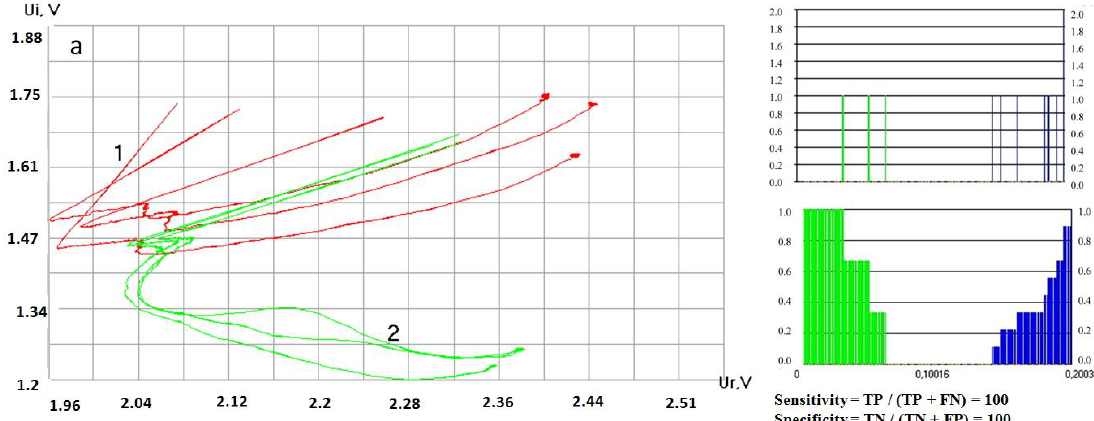
Figure 6. Software interface. ( a ) Hodographs of electrical impedance: sample 1—port wine “777” (Russia) and sample 2—vermouth “Martini Bianko” (Italy). ( b ) Intermediate data for calculating proximity measures between sample 1 and sample 2: green shows the distance between hodographs for sample 1; blue shows distances between hodographs for sample 1 and hodographs for sample 2. Ordinate - axis is the number of measurements for given DI values. The abscissa is the DI values. ( c ) Joint distribution of the estimates for errors of the second kind (green) and errors of the first kind (blue) versus DI value with the calculation of sensitivity and specificity [32].